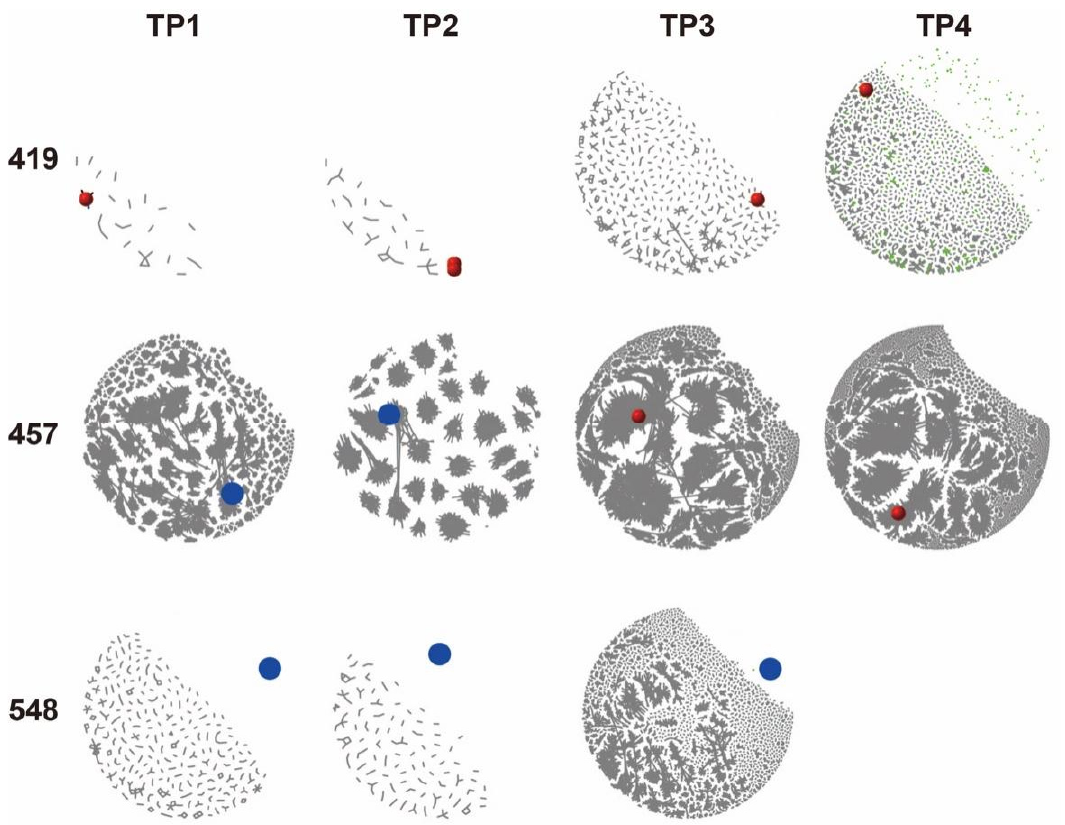
Figure 5. Network plots of the IgKappa (Ig κ ) CDR3 repertoires from the three patients with available tumor samples. The primary cluster tumor BCR clones were spiked-in, in which red spheres denoted minimally residual disease (MRD) existing in the patients’ blood samples, while blue circles denoted tumor clones not detected in the blood samples. Green circles/dots denoted normal peripheral BCR clones connected by gray lines for evolutionary relation. The layout of nodes on the network plot was based on the Levenshtein distance (LD) between nodes (clones). Patient 548’s peripheral BCR repertoire had no clone that was related to his tumor BCR clone.